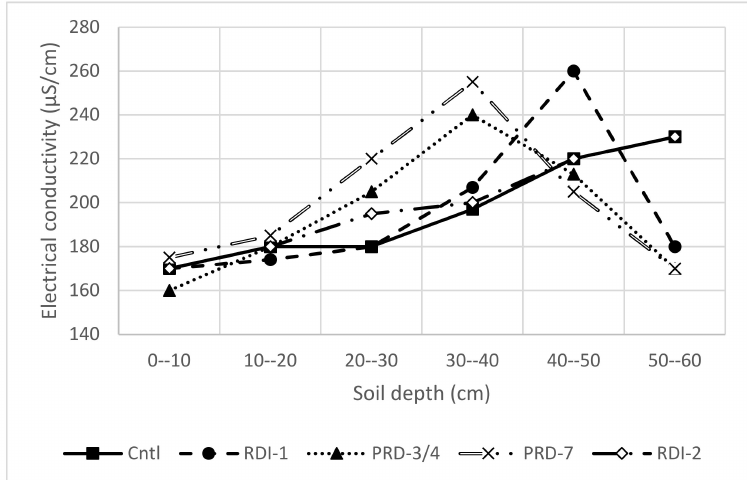
Figure 7. Pattern in soil electric conductivity according to soil depth and irrigation